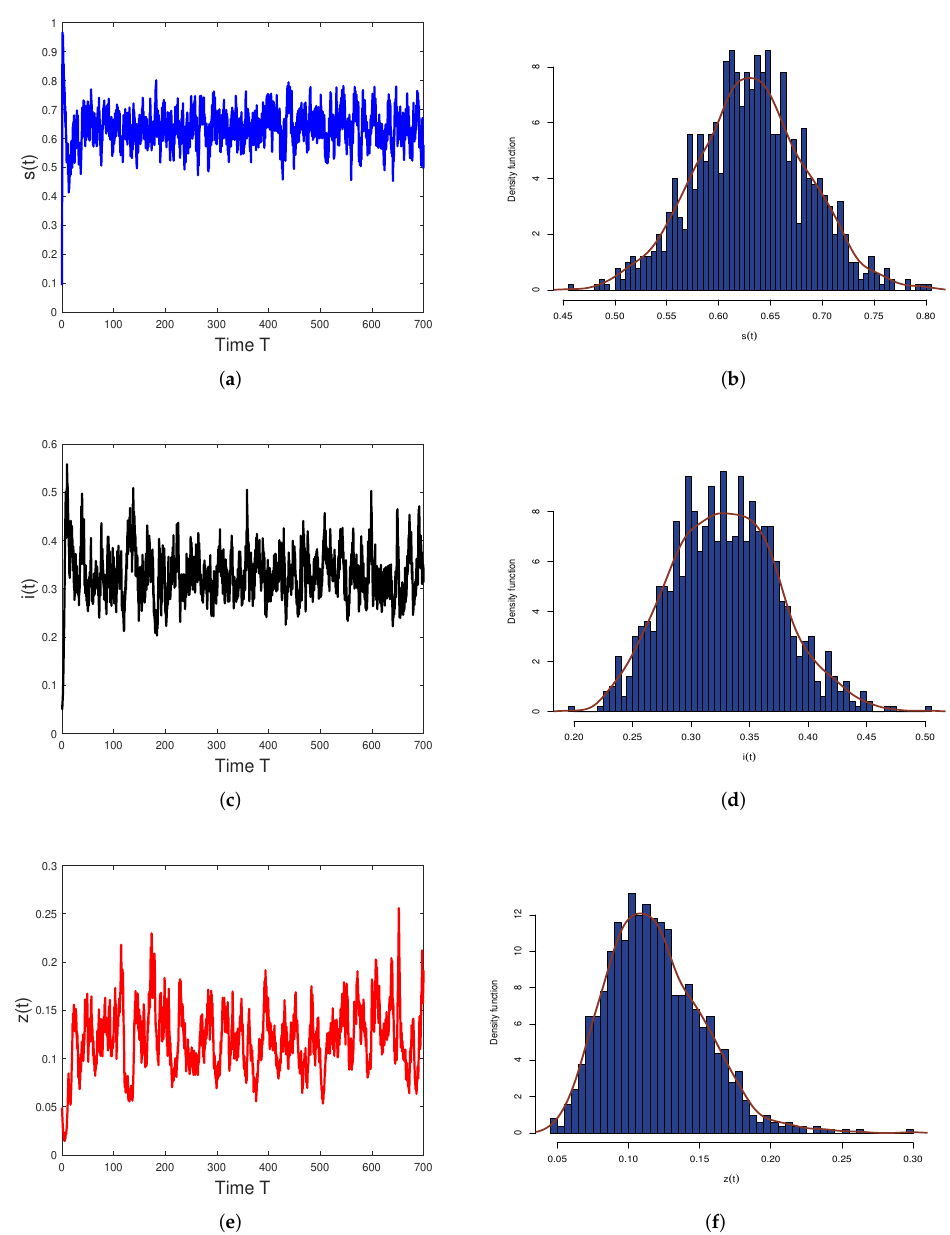
Figure 1. Susceptible phytoplankton s ( t ) , infected phytoplankton i ( t ) , and zooplankton z ( t ) are persistent in the mean with probability one, based on the parameter values in Table 1 and σ i = 0.01 ( i = 1,2,3 ) . The initial value is ( 0.08,0.06,0.05 ) . ( a – f ) denote the evolution of a single path and